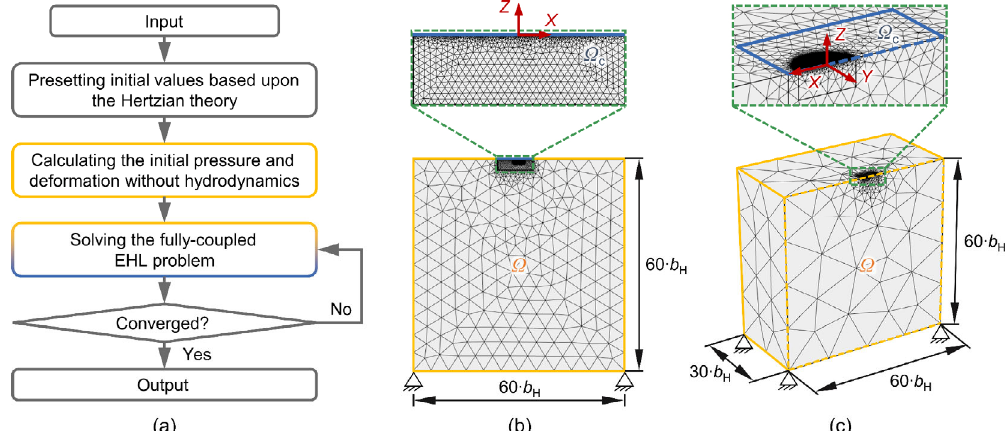
Fig. 4 (a) Schematic of the numerical solution of the EHL model and computational domains with meshing and boundary conditions for (b) infinite 2D line and (c) 3D circular point